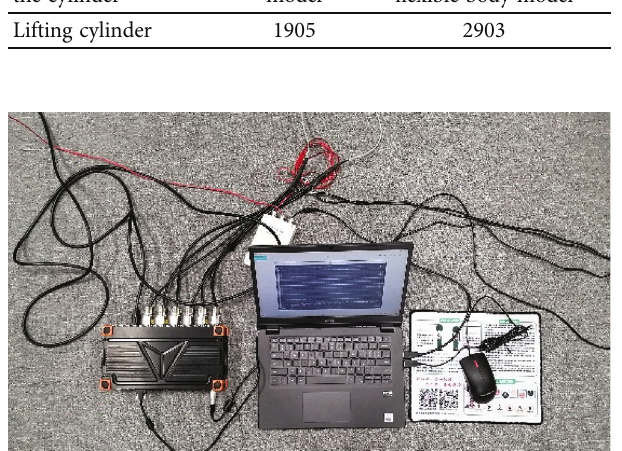
Figure 7: 32-Channel Dewesoft dynamic signal test acquisition and processing instrument.